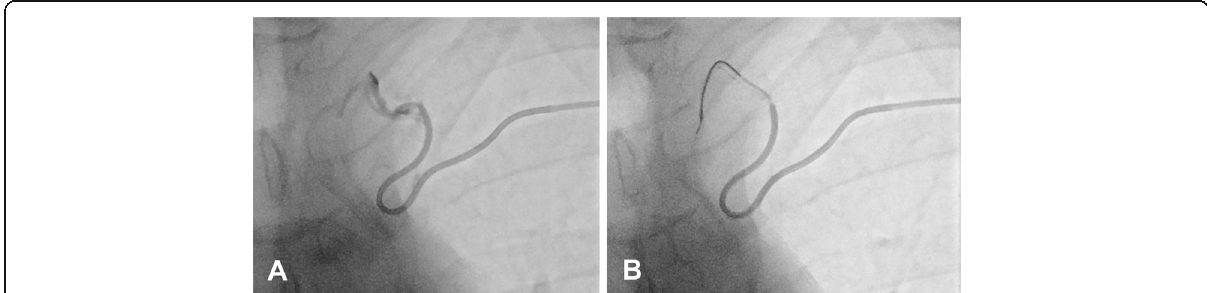
Fig. 2 Retrograde transvenous embolization of the thoracic duct. a Mikaelsson catheter in the left subclavian vein with ductography of the cervical course of the thoracic duct. b Microcatheter inserted in the cervical part of thoracic